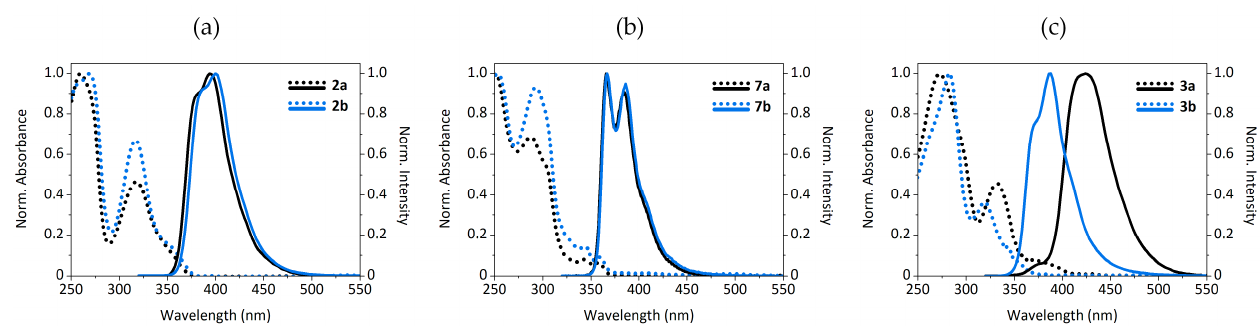
Figure 3. Absorption (pointed) and emission (solid, λ ex = 300 nm) spectra in CH 2 Cl 2 of compounds: ( a ) 2a – b ; ( b ) 7a – b ; ( c ) 3a – b .